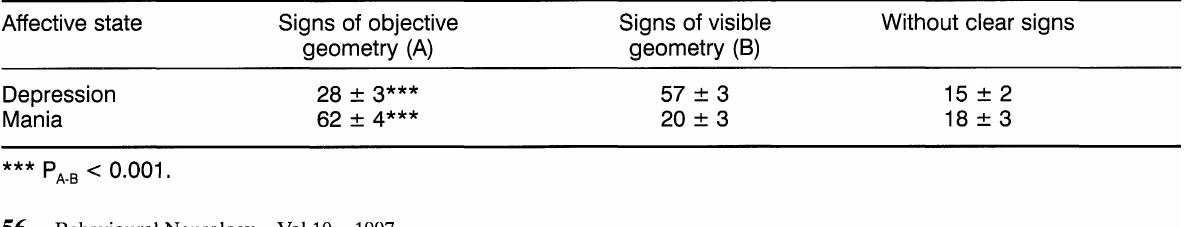
TABLE III. Frequency (%) of representation of visible and objective geometry of space in the drawings of depressed and manic patients Affective